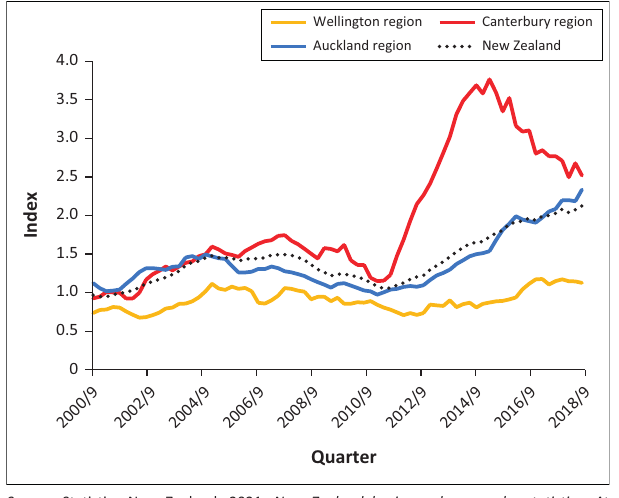
FIGURE 1: Consent–gross domestic product index, 2000–2019 – Index to New Zealand